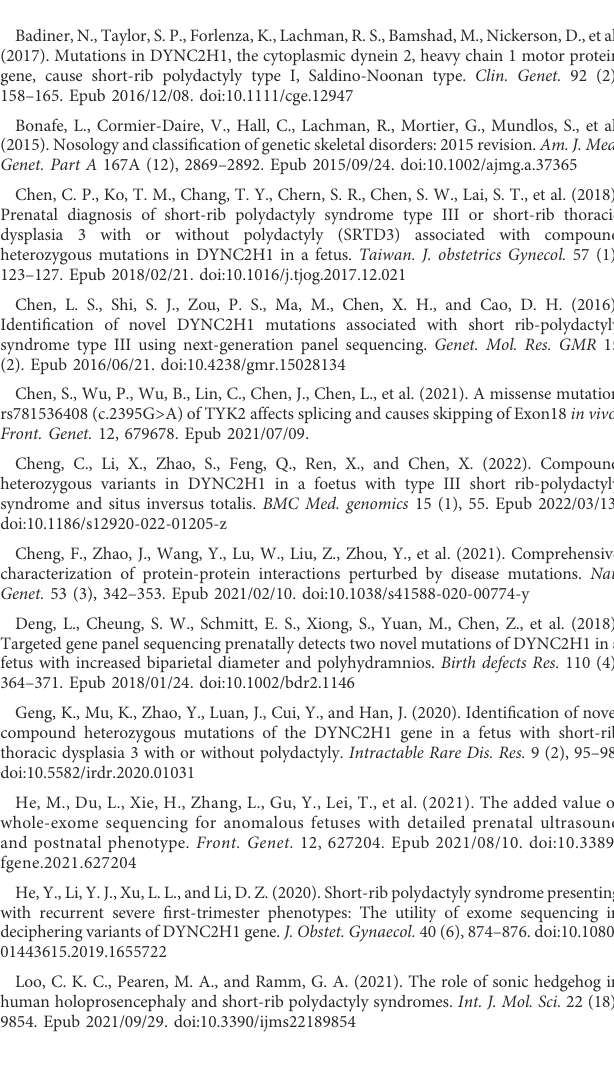
SUPPLEMENTARY TABLE S1 Detailed variants list of case 1 observed in WES. SUPPLEMENTARY TABLE S2 Detailed variants list of case 2 observed in WES. SUPPLEMENTARY TABLE S3 Detailed variants list of case 3 observed in WES. SUPPLEMENTARY TABLE S4 Detailed variants list of case 4 observed in